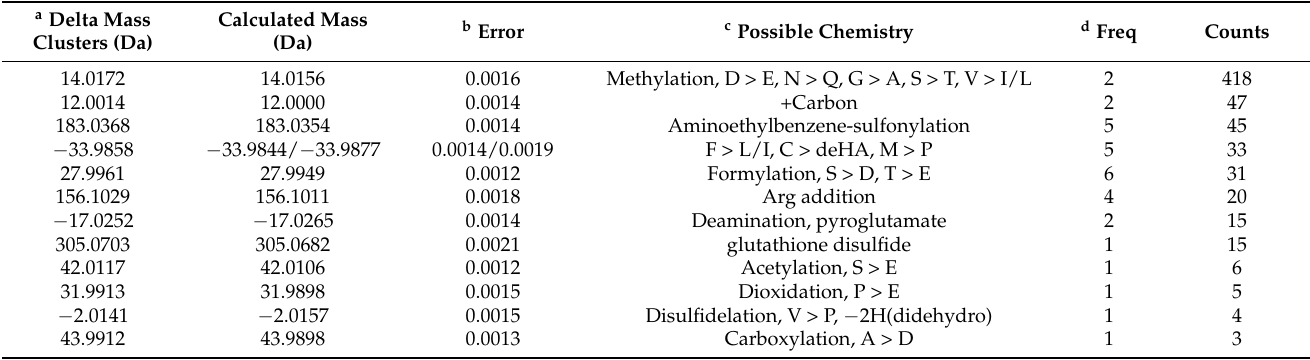
Table 1. Ischemia-associated delta mass clusters (R 2 > 0.5, ratio > 2-fold, p <